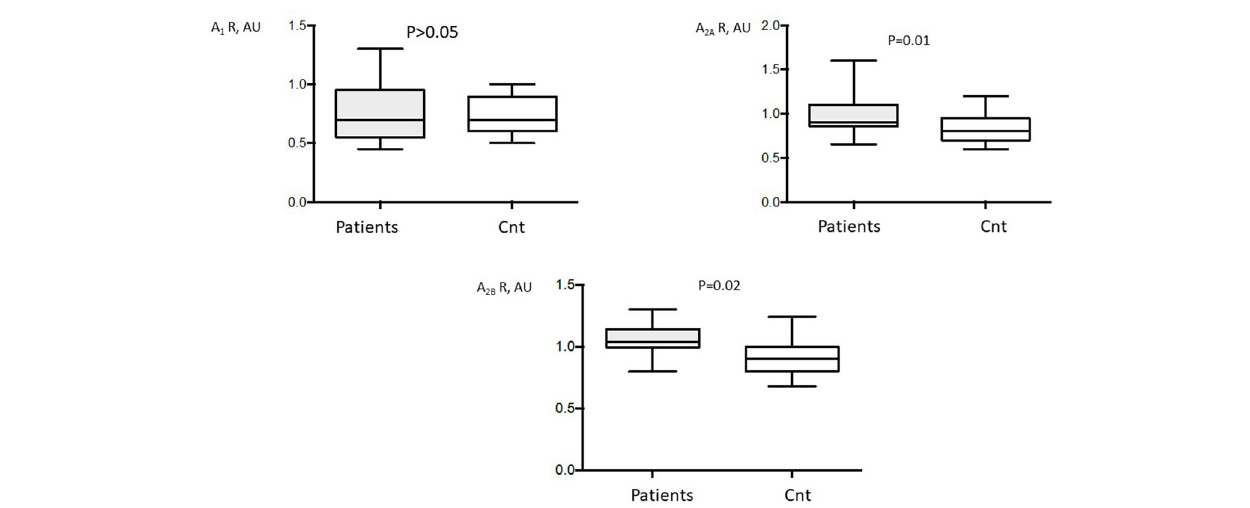
FIGURE 2 | Adenosine receptor (AR) production in A 1 (A 1 R), A 2A , (A 2A R), and A 2B (A 2B R) adenosine receptors of patients undergoing cardiac surgery ( n = 39). Production of adenosine receptors was performed by western blot in peripheral blood mononuclear cells (PBMCs). Control western blotting was performed on PBMC from 20 control subjects (Cnt). AU, arbitrary units. Box indicates mean ± SD and vertical lines indicate the